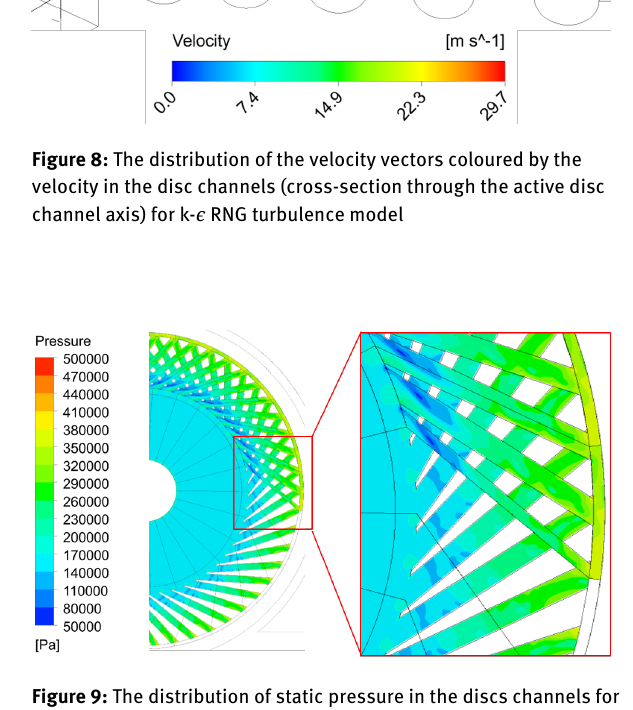
Figure 9: The distribution of static pressure in the discs channels for k- ϵ RNG turbulence